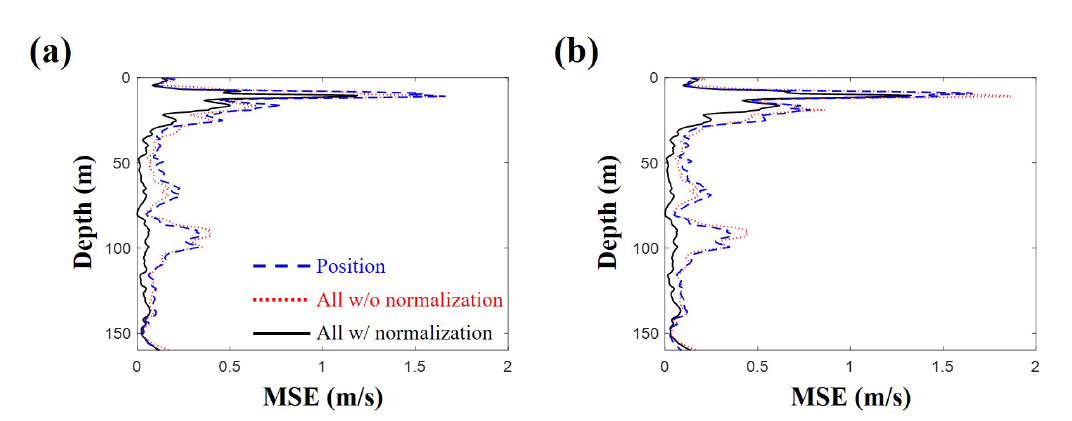
Figure 14. Mean squared errors of estimated sound speed profiles from true values are calculated according to different objective functions using arrivals less than ( a ) 30 ◦ and ( b ) 20 ◦ , respectively. The inversion using all ray information after normalization outperforms the others. The reduction of available ray number has a slight effect on the performance in terms of mean squared